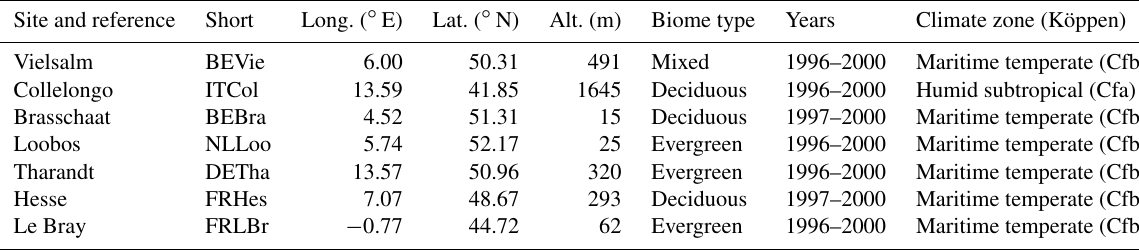
Table 1. Overview of the FLUXNET eddy-covariance sites used in this study. Site and reference